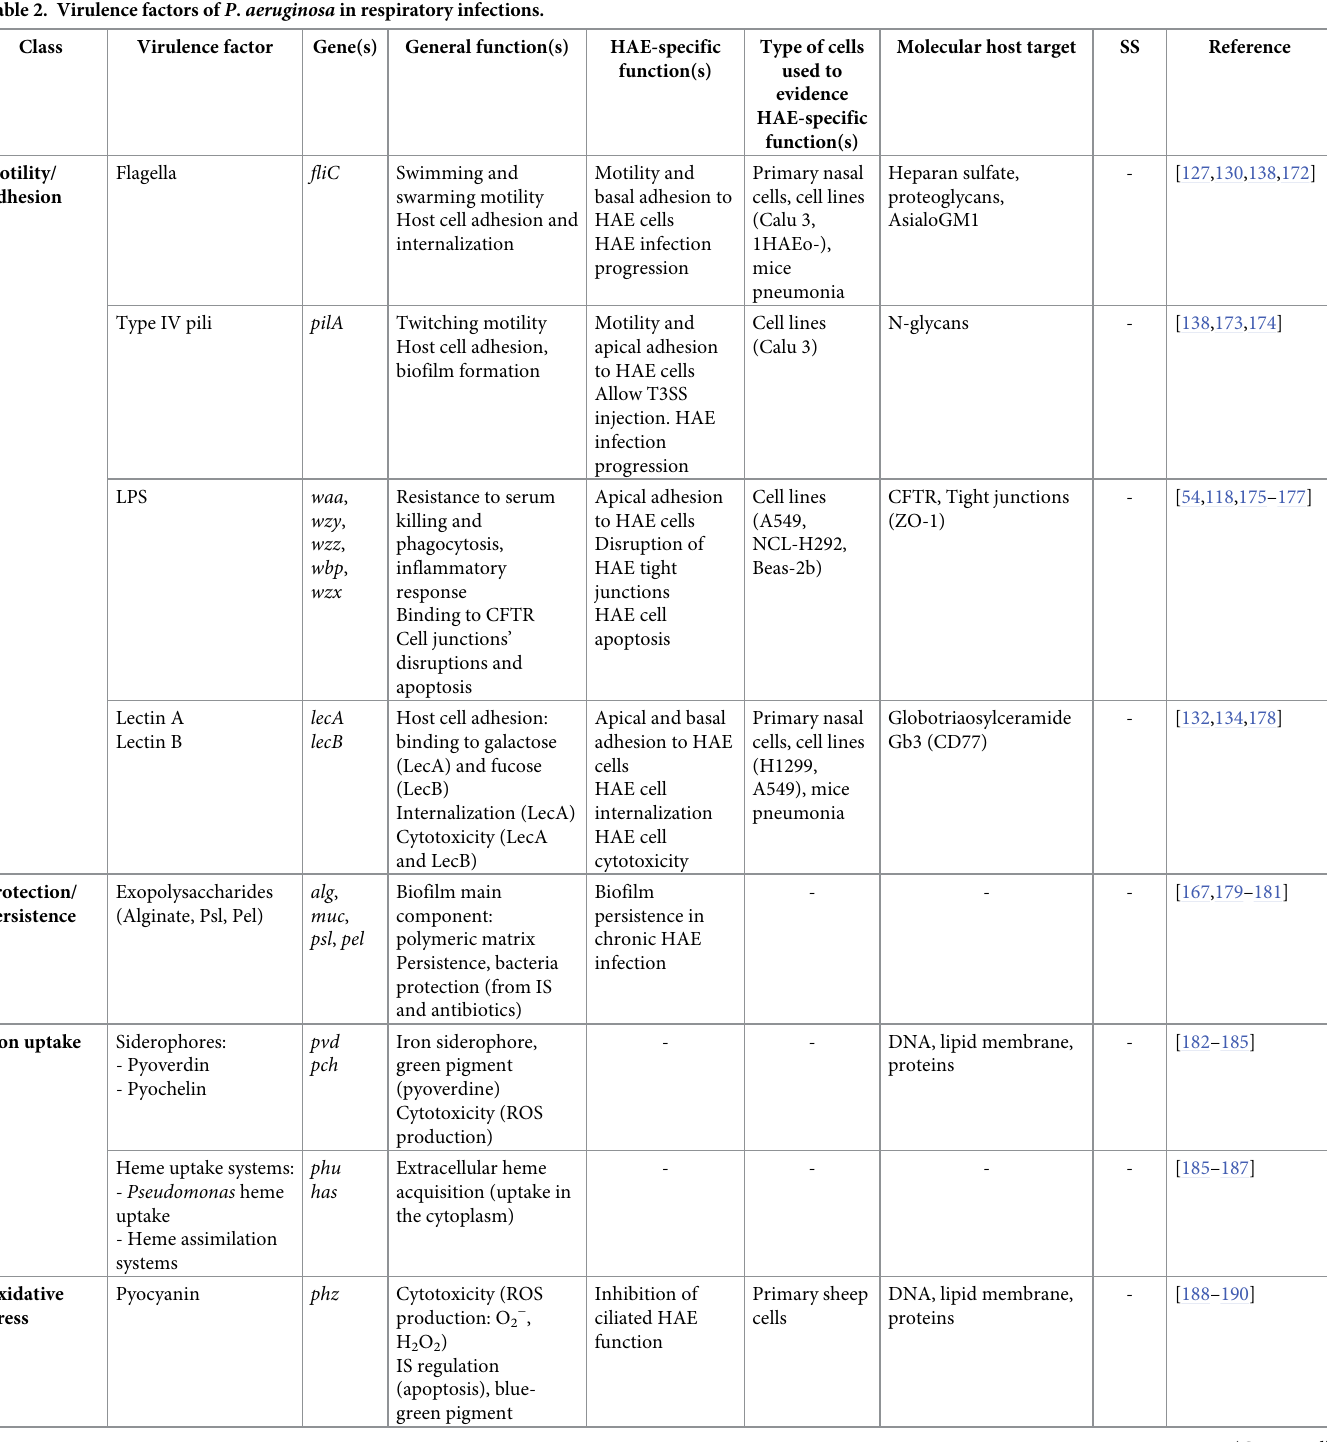
Table 2. Virulence factors of P . aeruginosa in respiratory